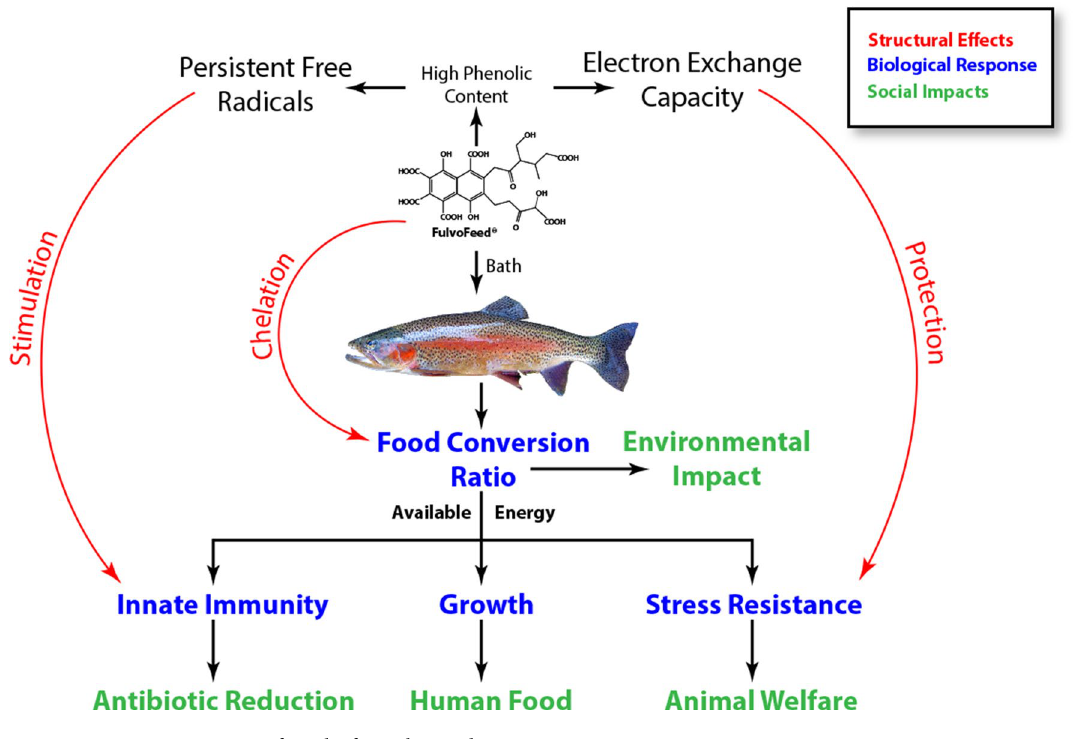
Figure 6. Overview of results from this